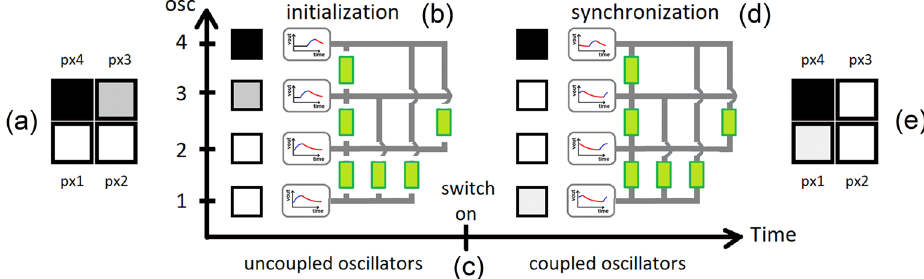
Figure 1. Example of possible ONN application for image recognition tasks. ( a ) Input image. ( b ) Initialization of ONN circuit. Each pixel of input image is mapped as oscillator’s phase (cid:31)(cid:30) in,j by delaying of (cid:31) t in,j the biasing V DD,j compared to the reference (bottom-most) oscillator. The computation begins at coupling of all the oscillators ( c ), where the simplest coupling elements are resistances R C,i,j (green blocks). ( d ) The oscillators synchronize in a stable in-phase ( (cid:31)(cid:30) out,j = 0 ◦ ) or out-of-phase ( (cid:31)(cid:30) out,j = 0 ◦ ) state. The phase of each oscillator is mapped back as pixel (gray scale) color to yield the ( e ) output image.